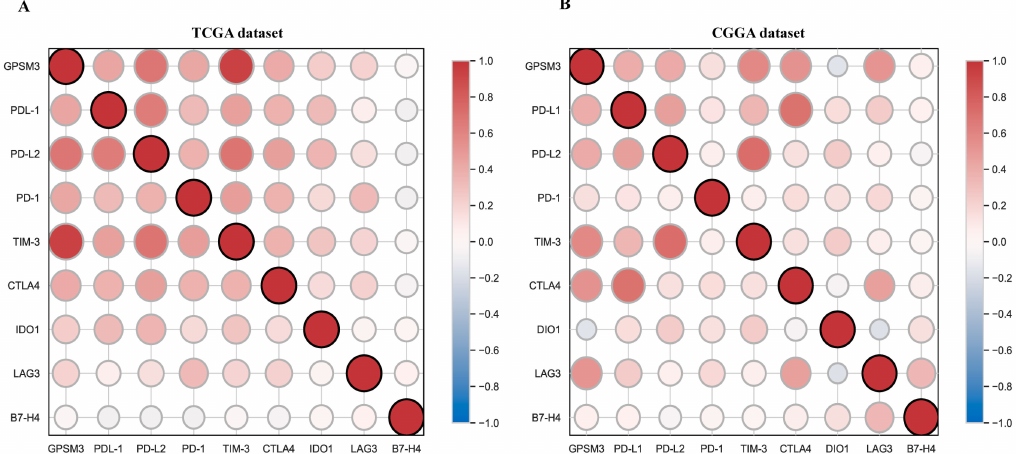
Figure 8. Correlation analysis between GPSM3 and immune checkpoints. ( A ) Correlation matrix plots of GPSM3 and major immune checkpoints in the TCGA dataset. ( B ) Correlation matrix plots of GPSM3 and major immune checkpoints in the CGGA